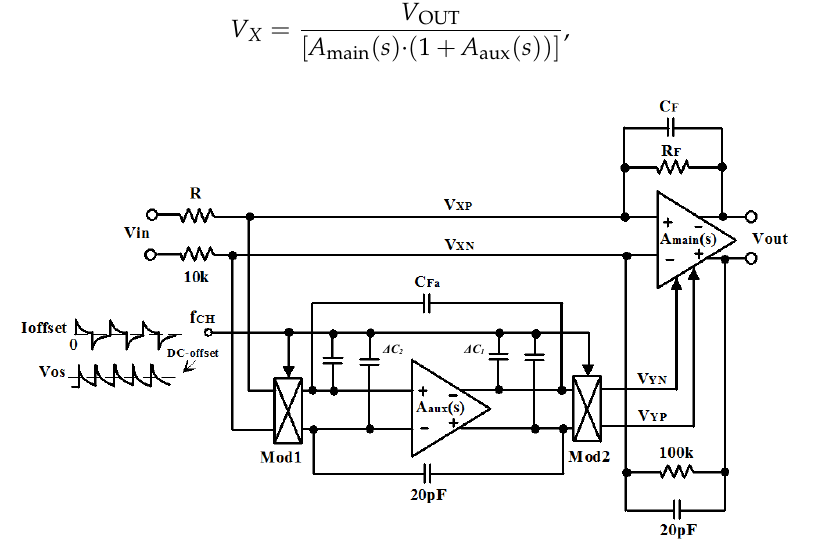
Figure 1. Chopper stabilization preamplifier.